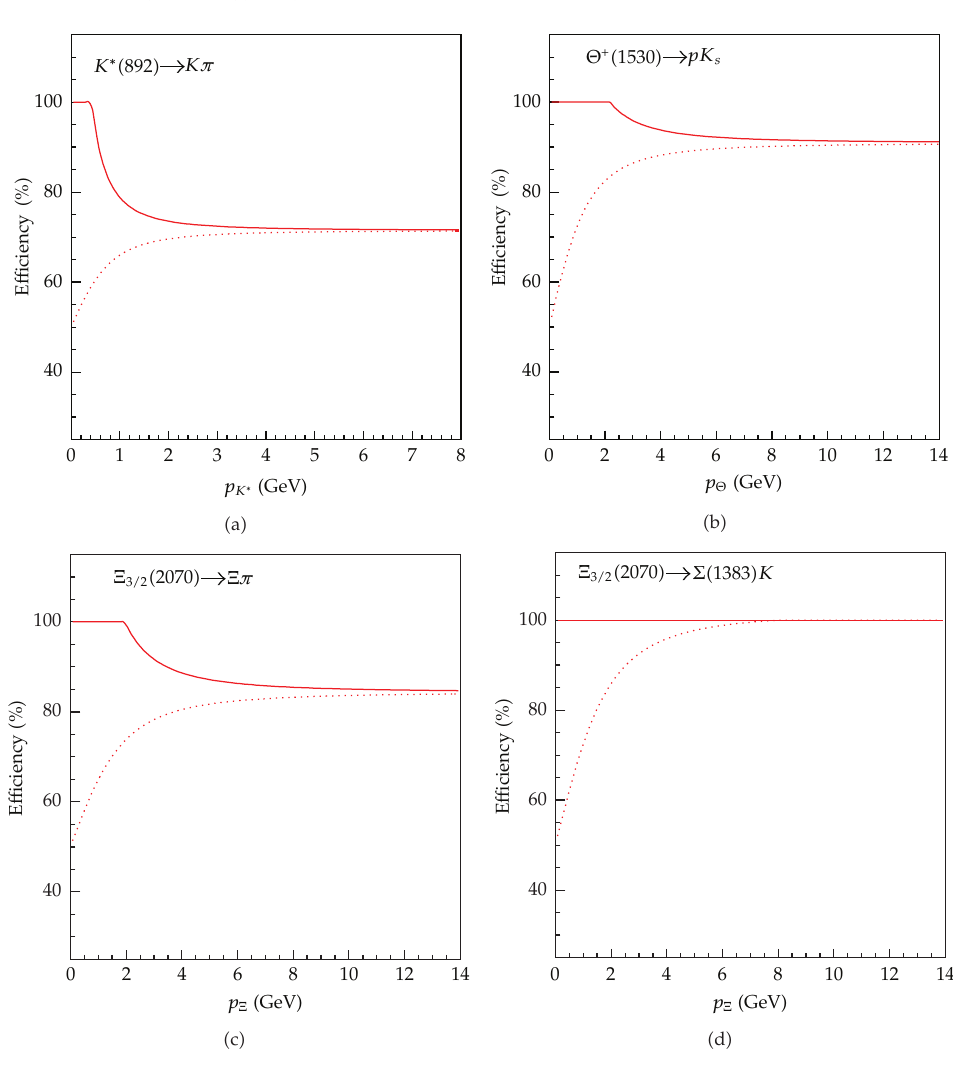
Figure 4: E ffi ciency of the selection rule p a > p b (cid:3) dashed line (cid:4) and E a > E b (cid:3) full line (cid:4) at di ff erent P R in decays of K ∗ (cid:3) 892 (cid:4) , Θ(cid:3) 1530 (cid:4) , and Ξ 3 / 2 (cid:3) 2070 (cid:4)